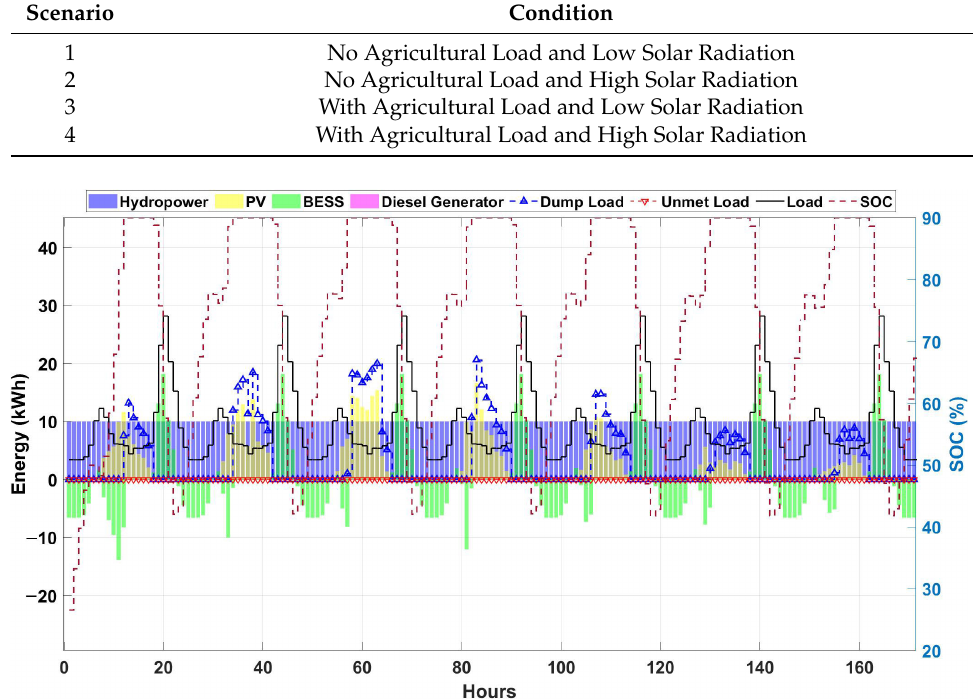
Figure 19. Energy scheduling—Scenario 1—no agricultural load and low solar radiation.